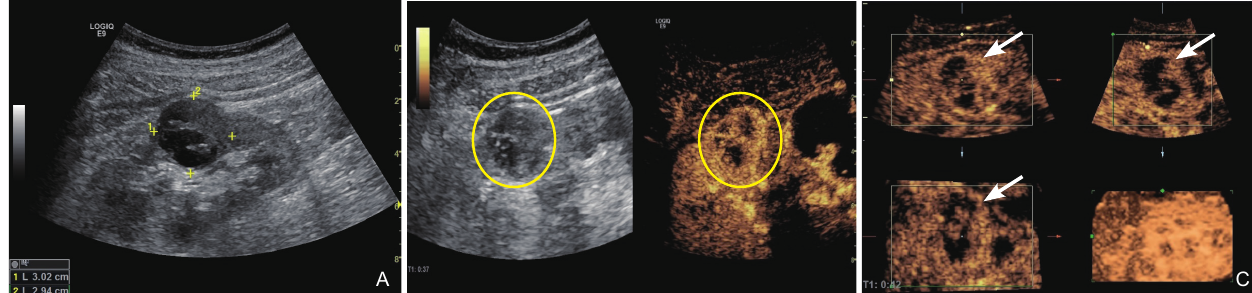
Figure 8 Example of 2D and 3D CEUS of a Clear cell RCC with cystic features. (A) Grey-scale image demonstrating a hypoechogenic 3 × 2.9 cm renal mass; (B) 2D dual imaging shows a diffuse, heterogeneous enhanced tumor with both solid and cystic components during the arterial phase (37 seconds post-UCA injection); (C) Continuous CEUS 3D imaging was subsequently performed following a second bolus injection. The tumor is well visualized in three orthogonal planes (white arrows) and in the volumetric reconstruction (bottom right panel).